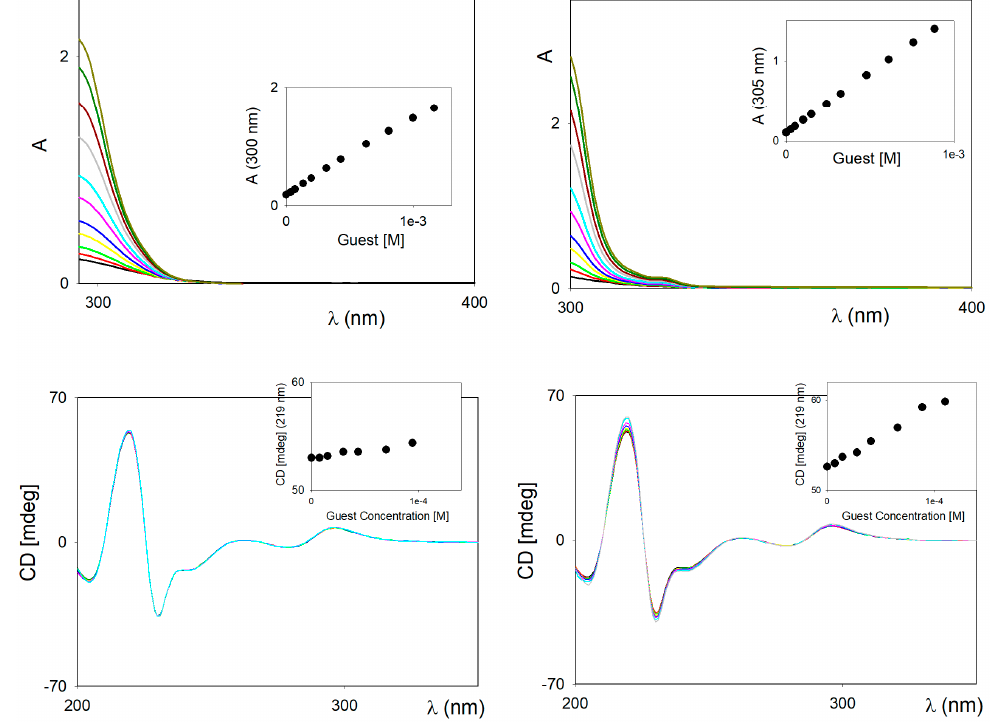
Figure 3. UV ( top ) and CD ( bottom ) titration of macrocycle 5a and hydroquinone ( left ) and 1,4-dimethoxybenzene ( right ). Concentrations: 10 − 5 M for UV and 10 − 6 M for CD spectroscopy in MeCN.